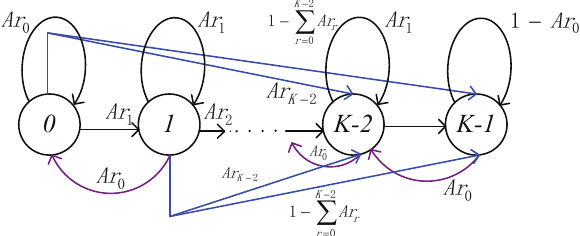
Figure 3. The relationship between π a and Ar a